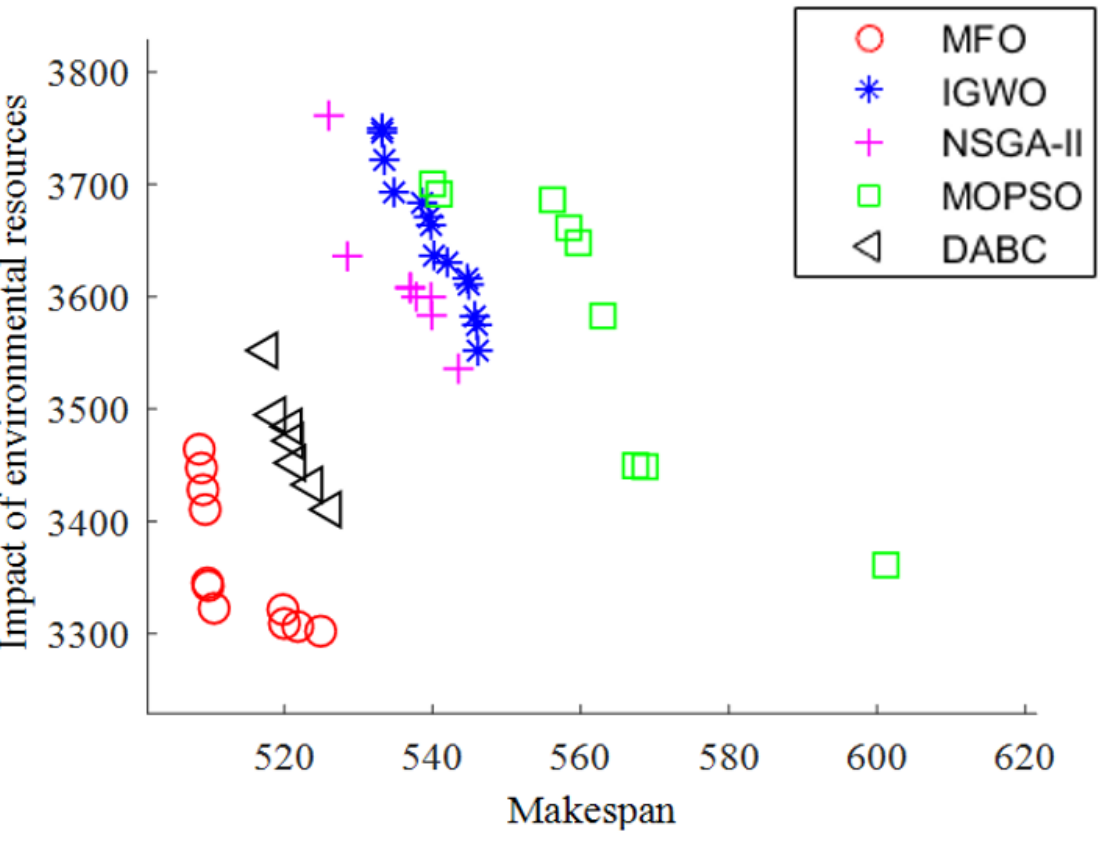
Figure 7. Pareto first frontier distribution map. For L2I6J14-2, the green reentry mixed-flow shop-scheduling problem was solved using the IMFO algorithm. The solution obtained is presented in Figure 8. Herein, the abscissa indicates the processing time, and the ordinate indicates the processing station, wherein numbers 1–6 correspond to the first process and 6–12 correspond to the second process. The processing time for obtaining the solution was 518 h.